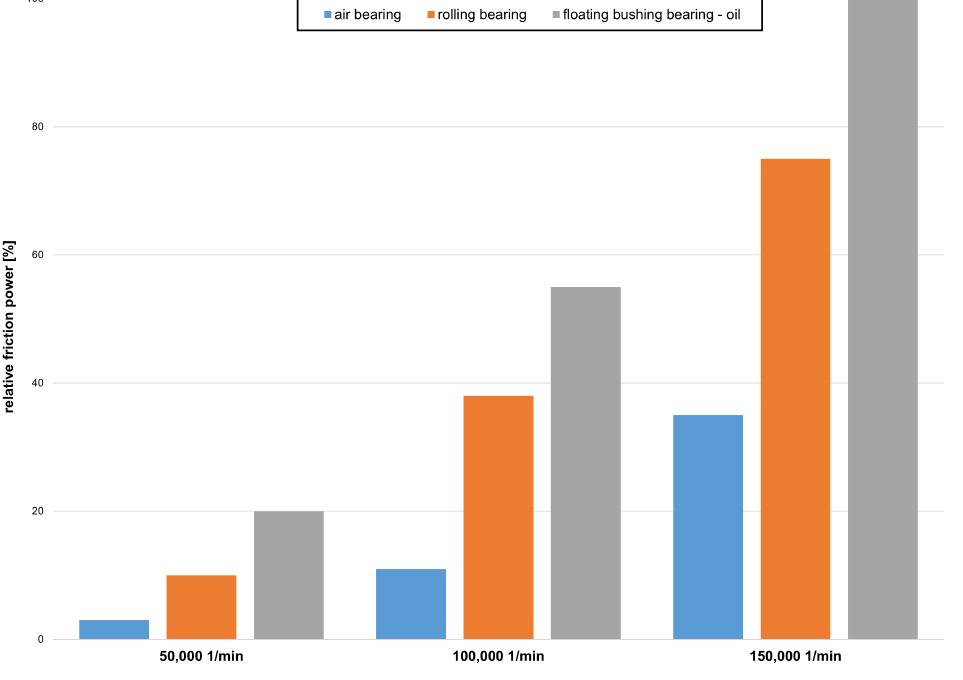
Figure 2. Comparison between different bearing systems of start up simulations in turbomachinery, based on